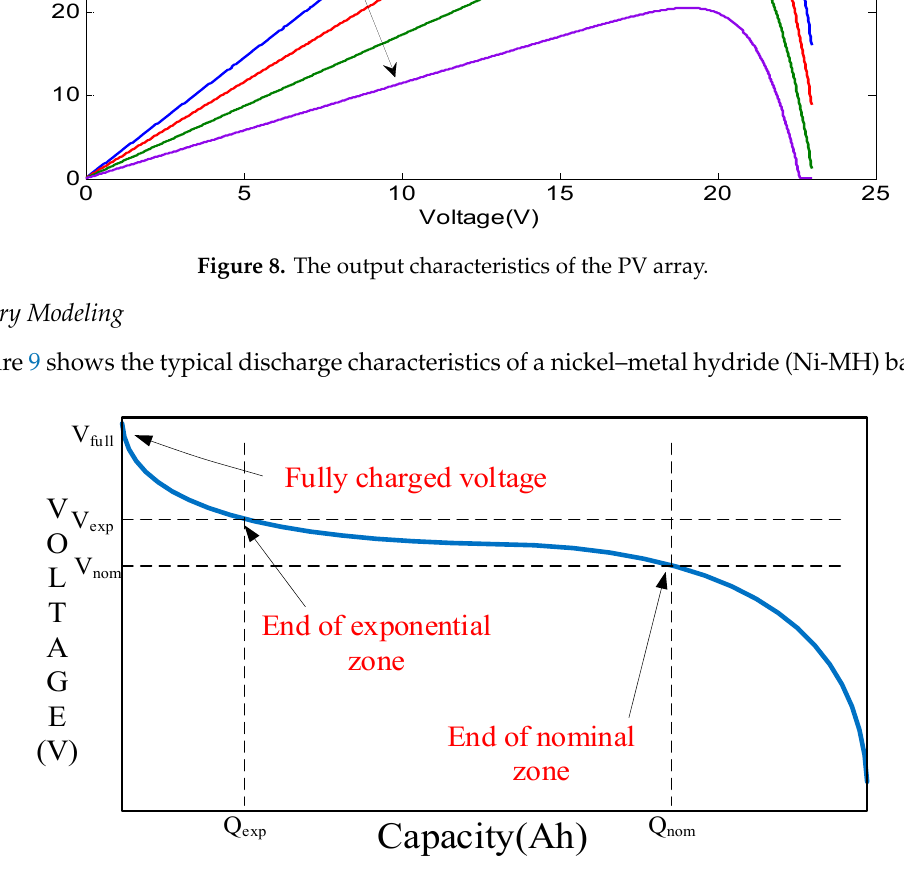
Figure 9. The typical discharge characteristics of nickel–metal hydride (Ni-MH).